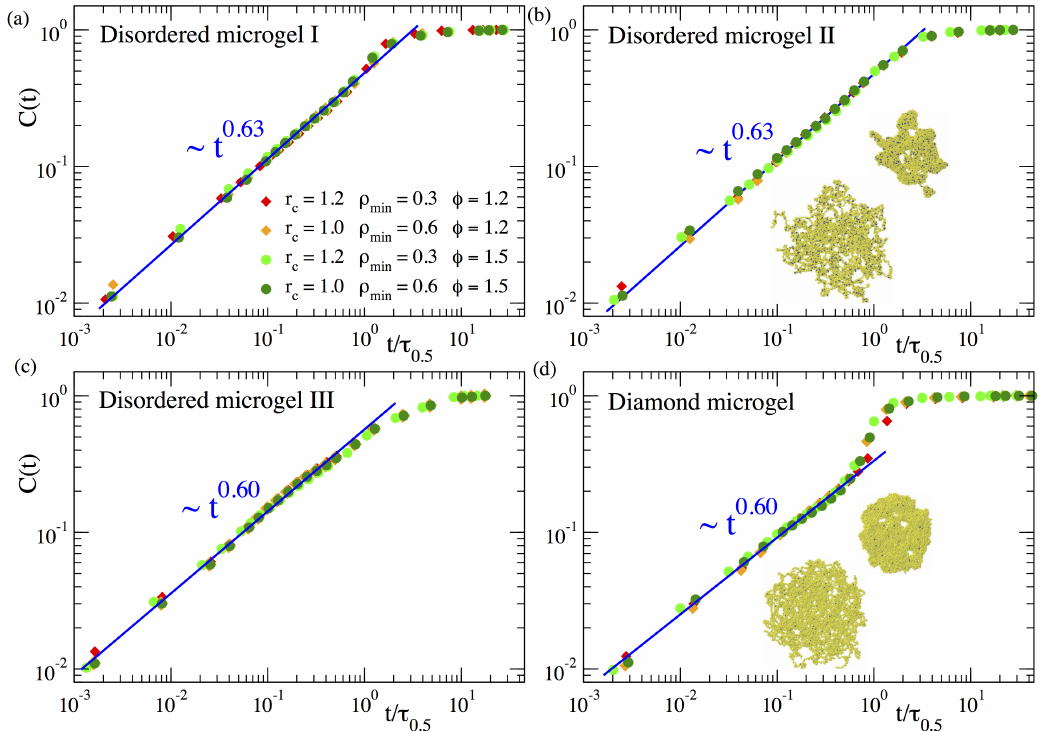
Figure 3. Relative domain size C ( t ) over time during the collapse at φ = 1.2 and φ = 1.5 of three disordered microgels of small ( a ), middle ( b ) and large asphericity ( c ) and of a diamond microgel ( d ). Different datasets correspond to different values of the parameters r c and ρ min used to construct the density field. The time t is normalized by τ 0.5 , defined as the time when C = 0.5. Straight lines in all panels fit to a power-law time dependence. Exponents are indicated. In panels ( b , d ) we show typical simulation snapshots at early and intermediate